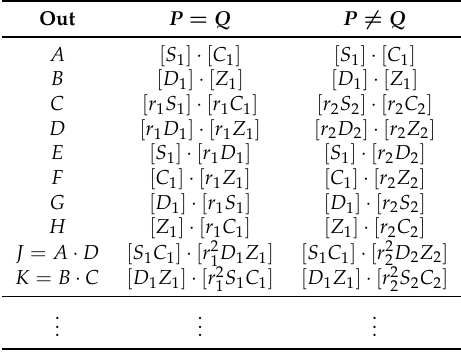
Table A5. Unified point addition for the Jacobi intersection elliptic curve